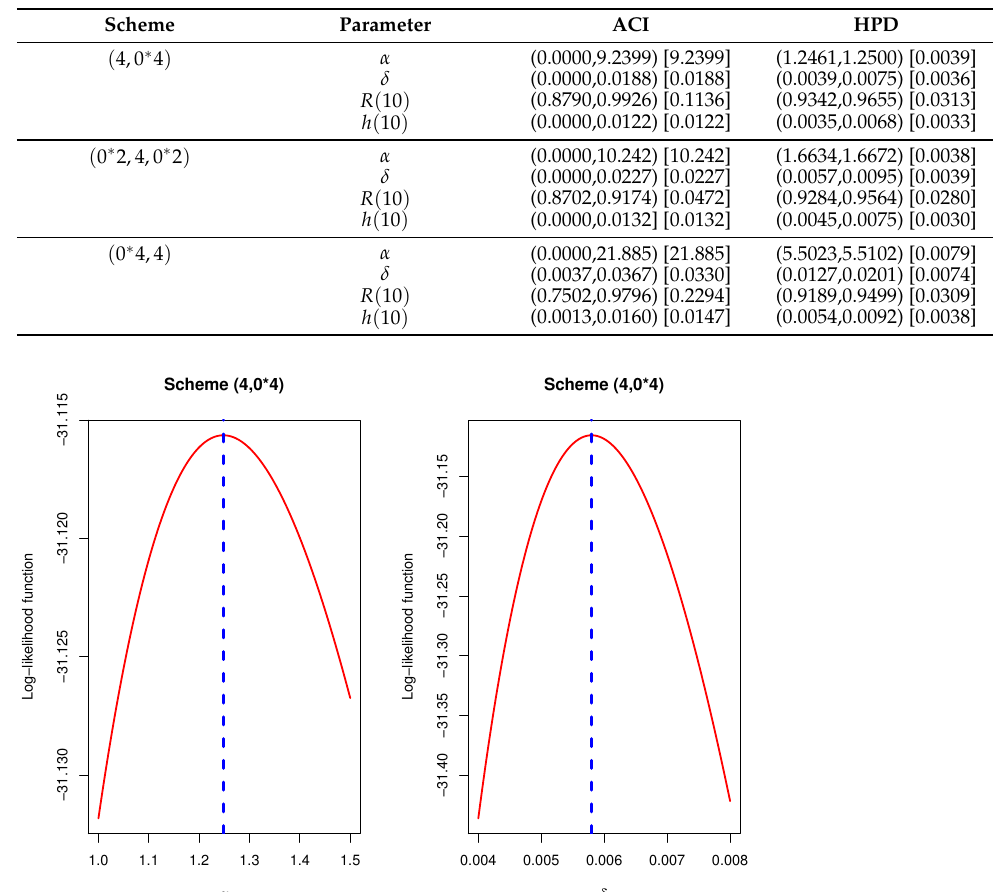
Table 13. The interval estimates [lengths] of α , δ , R ( t ) , and h ( t ) using electronic devices data.